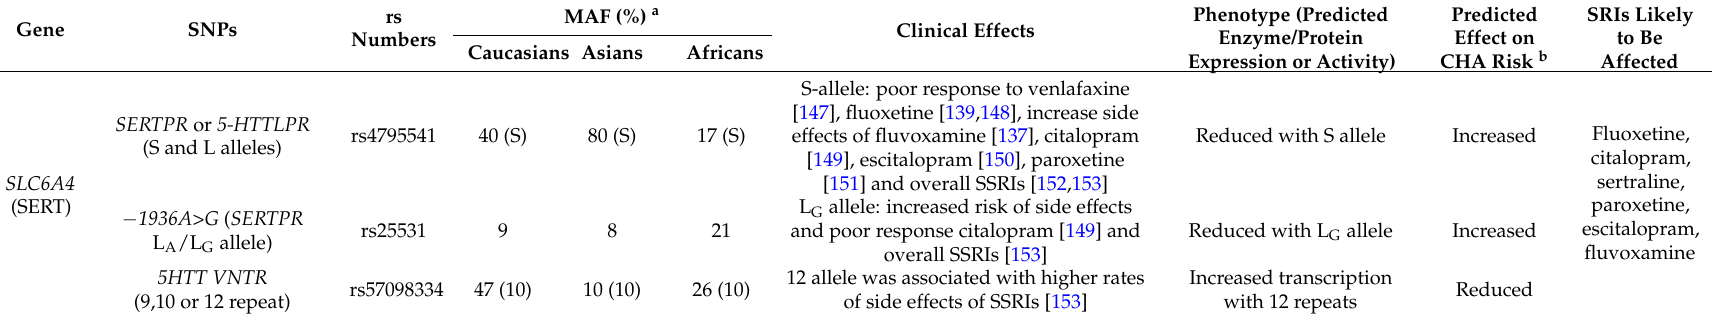
Table 2. Polymorphisms of the serotonin transporter (SERT) and their predicted effect on congenital heart anomalies (CHA) risk in offspring exposed in utero.